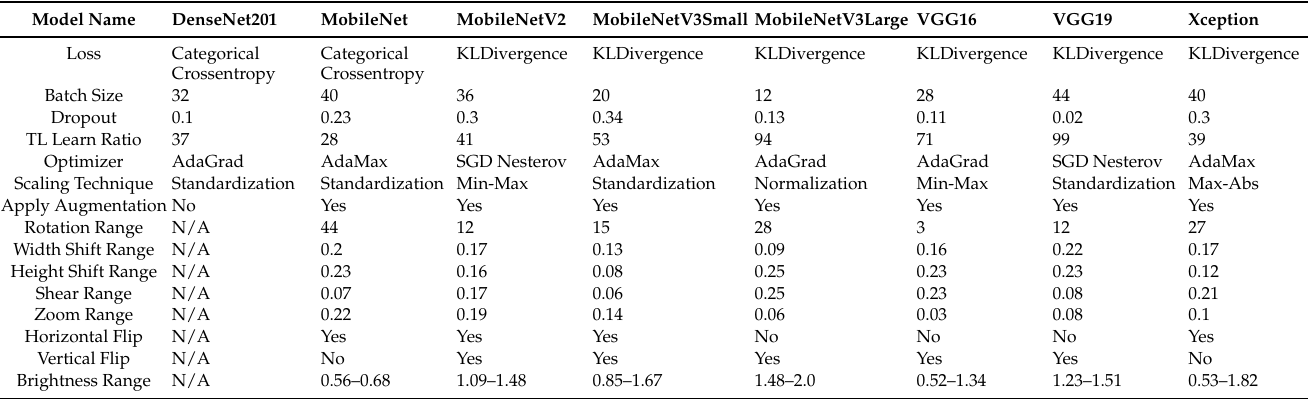
Table 8. The best hyperparameters for each pretrained CNN model using the “Alzheimer’s Disease Neuroimaging Initiative (ADNI)” dataset.